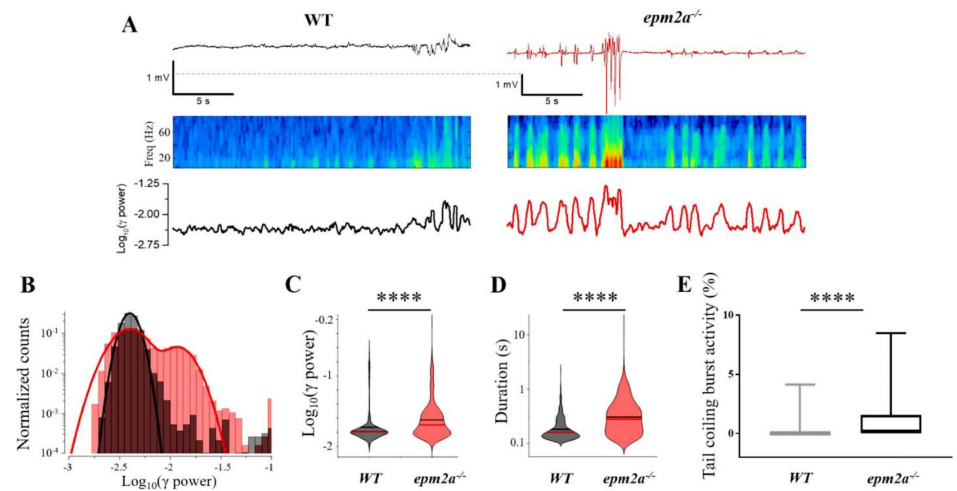
Figure 4. LFP and burst activity recordings in epm2a − / − zebrafish mutants. ( A ) (Top) Snap- shot of 25 s–long extract of LFP signal recorded from 120 hpf WT (left) and epm2a − / − (right) ze- brafish showing differences in burst activity. The relative spectrogram (Middle) and power in the 30–95 Hz band computed on a rolling window of 250 ms in steps of 50 ms (Bottom) are also shown. ( B ) Distribution of the log10 of the power in the 30–95 Hz band from the complete recordings (15 min) of the larvae depicted in panels A and B (WT in black and epm2a − / − in red). ( C ) and ( D ) Violin plots of the power and duration of the events detected from all the WT ( n = 11) and epm2a − / − ( n = 11) fish. Red and black lines indicate medians and means, respectively. ( E ) Coiling frequency recorded for 60 s at 30 hpf is increased in epm2a − / − embryos ( n = 157) with respect to WT controls ( n = 174). ****: p ≤ 0.0001 calculated by Mann-Whitney test.